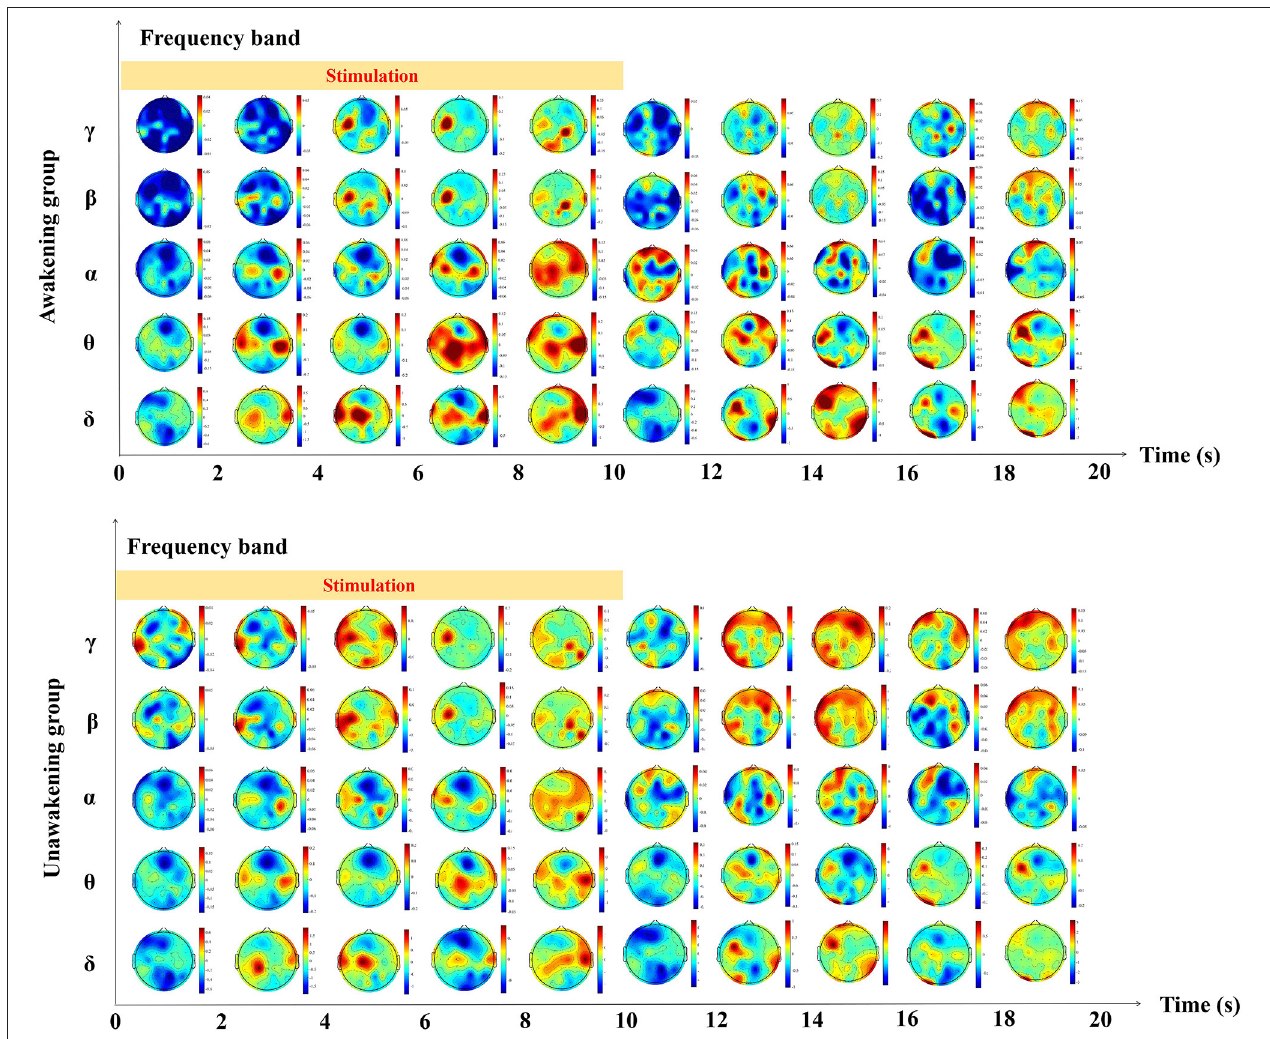
FIGURE 2 | The dynamic changes of the relative power spectrum along the